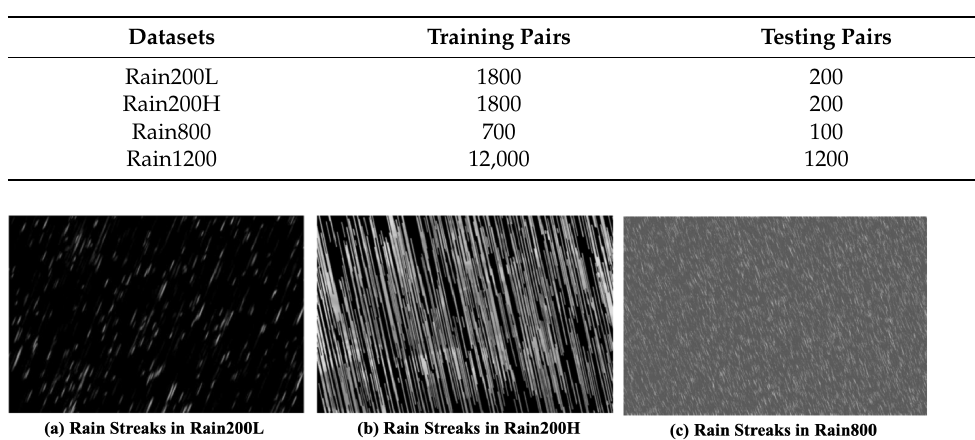
Figure 5. Sample rain streaks from deraining